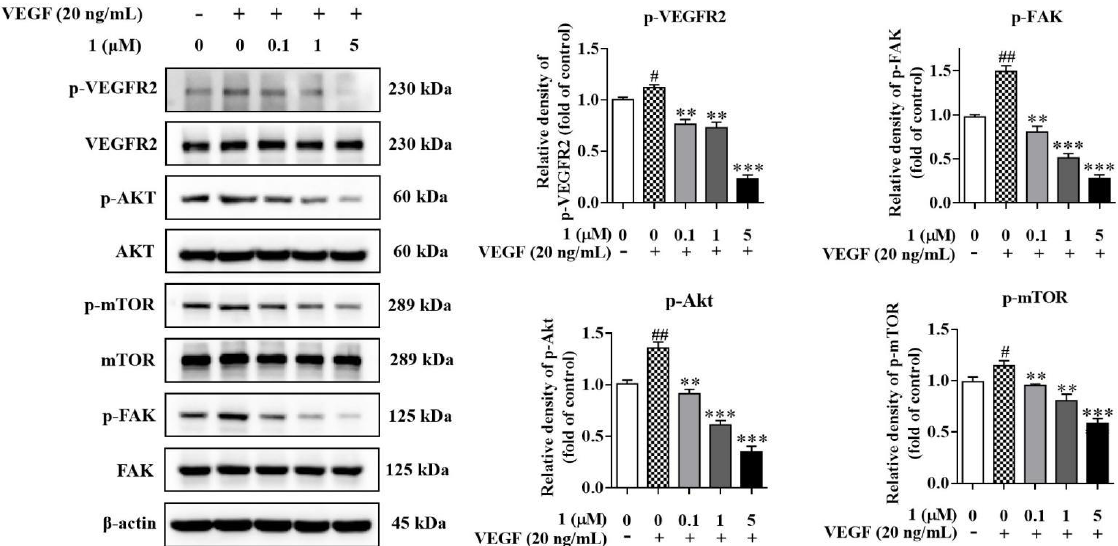
Figure 7. The effects of 1 on protein expression and phosphorylation levels of VEGFR2 and its downstream signaling pathways in HUVECs. The levels of p-VEGFR2, VEGFR2, p-Akt, Akt, p-mTOR, mTOR, p-FAK and FAK were determined by Western blots. ( n = 3, means ± SEM are shown, # p < 0.05, ## p < 0.01, compared with control; ** p < 0.01, *** p < 0.001, compared with VEGF only).